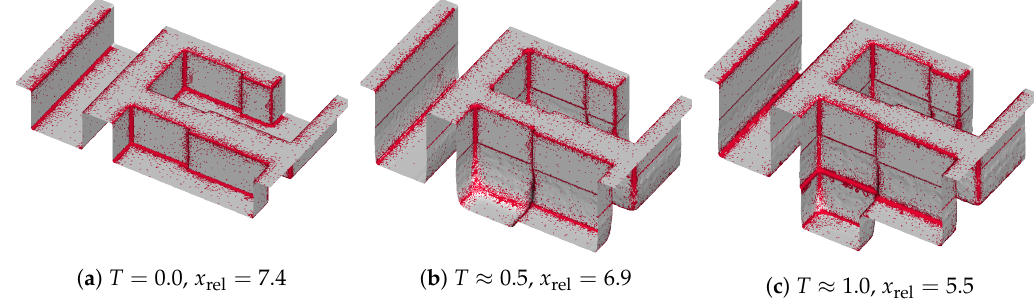
Figure 8. Active cells marked in red for d max = 32 using resolution 64 at different timesteps.